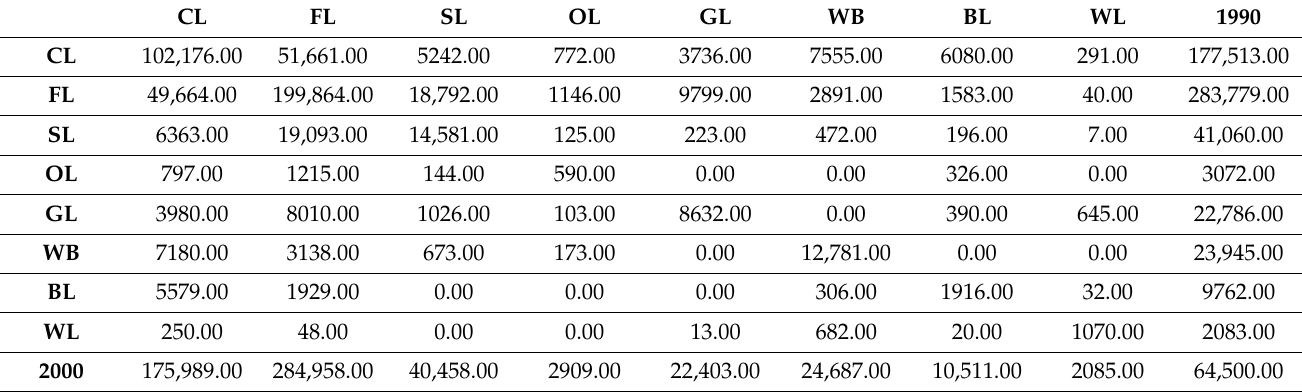
Table A3. Land use transfer matrix in the middle reaches of the Yangtze River from 1990 to 2000 (km 2